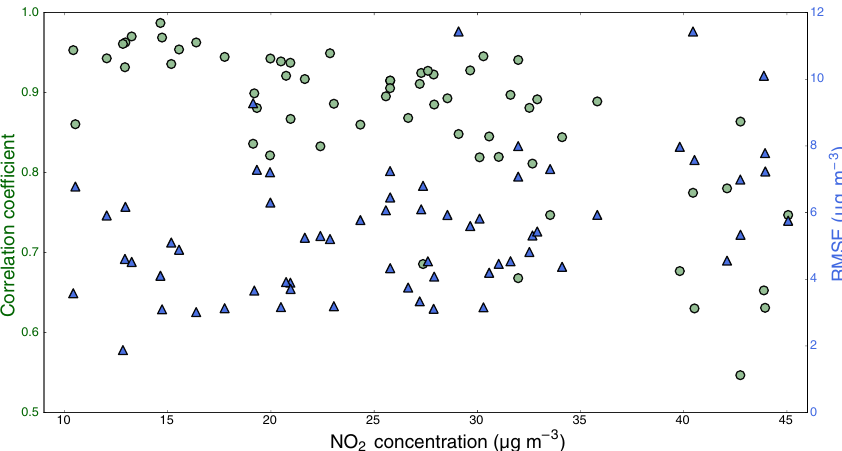
Figure 6. Correlation coefficients (green dots) and RMSE (blue triangles) at all passive samplers as a function of the mean NO 2 concentration at each site for the 2-year period 2013–2014. NO x simulations are converted to NO 2 using the parametrized conversion of Düring et al. (2011). The green and blue line corresponds to the correlation coefficient and RMSE, respectively, computed for 5µgm − 3 wide sliding concentration intervals by comparing 2-week averages of continuous NO 2 observations with converted equivalents of observed NO x .